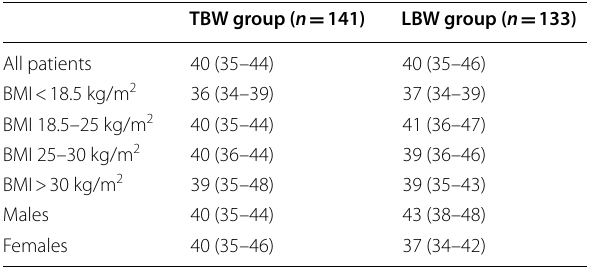
Table 3 Medians and interquartile intervals of Liver CE for subgroups of BMI and